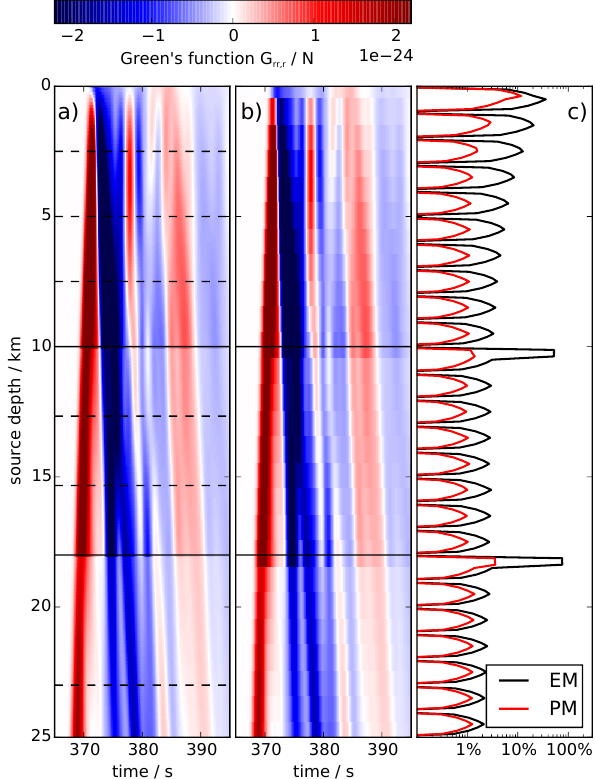
Figure 6. One component of the strain Green’s tensor ( G rr,r ) for a distance of 30 ◦ as a function of time and depth with a shortest period of 2s. (a) SEM basis vs. (b) regular sampling with 1km distance and (c) phase and envelope misfits (EM and PM in the legend, see Kristekova et al., 2009) caused by the regular sampling computed in the period range 1–20s. Dashed lines in the left panel sketch the spectral elements. The crustal discontinuities of ak135f (Montagner and Kennett, 1996) are indicated by solid lines and lead to disconti- nuities in G rr,r , which are exactly represented in the SEM basis.